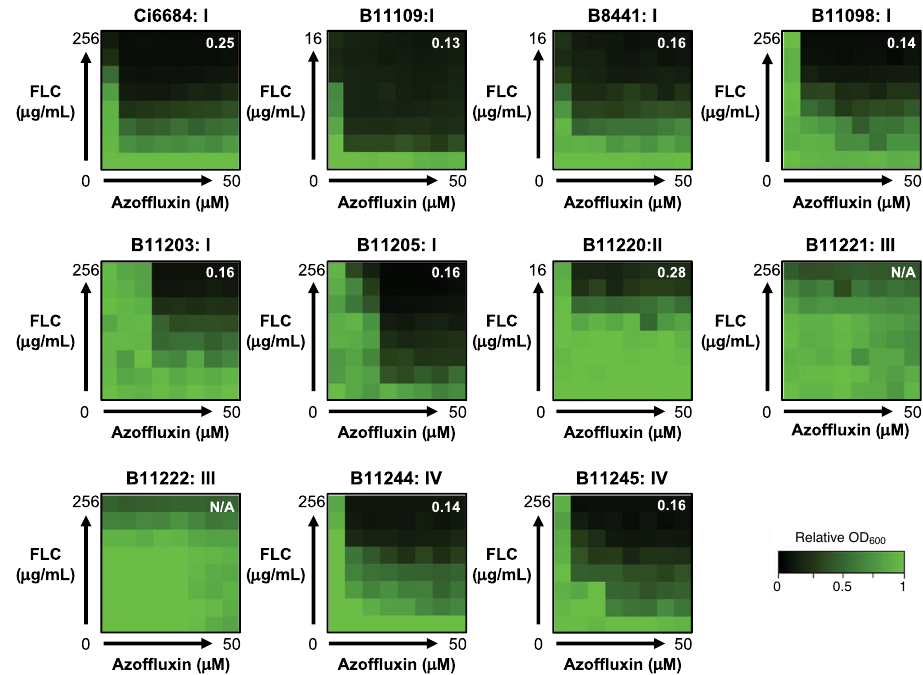
Fig. 4 Synergistic activity of azof fl uxin is clade speci fi c. Checkerboard assays were performed fl uconaozle (FLC) and azof fl uxin as described in Fig. 1b with isolates from each major clade of C. auris . CDC identi fi cation number is followed by the clade number to which the isolate belongs. Relative growth was measured in YPD medium after 24 h using OD 600 and normalized to a no-drug control well (see color bar). The FICI calculated for each checkerboard is shown in the top right of each plot, with values <0.5 indicating synergy, values >0.5 indicating no interaction, and N/A indicating an FICI that could not be calculated due to a lack of growth inhibition. Source data are provided as a Source Data fi F126L substitution in Erg11 7 and the absence of drug-resistance mutations in TAC1B , the transcriptional regulator of Cdr1 which are commonly found in clades I and IV 21 (e.g. the A640V sub- stitution in our screening strain VPCI 673/P/12). Examining whole genome sequences of 304 isolates representing each of the four major clades 7 , identi fi ed a unique non-synonymous